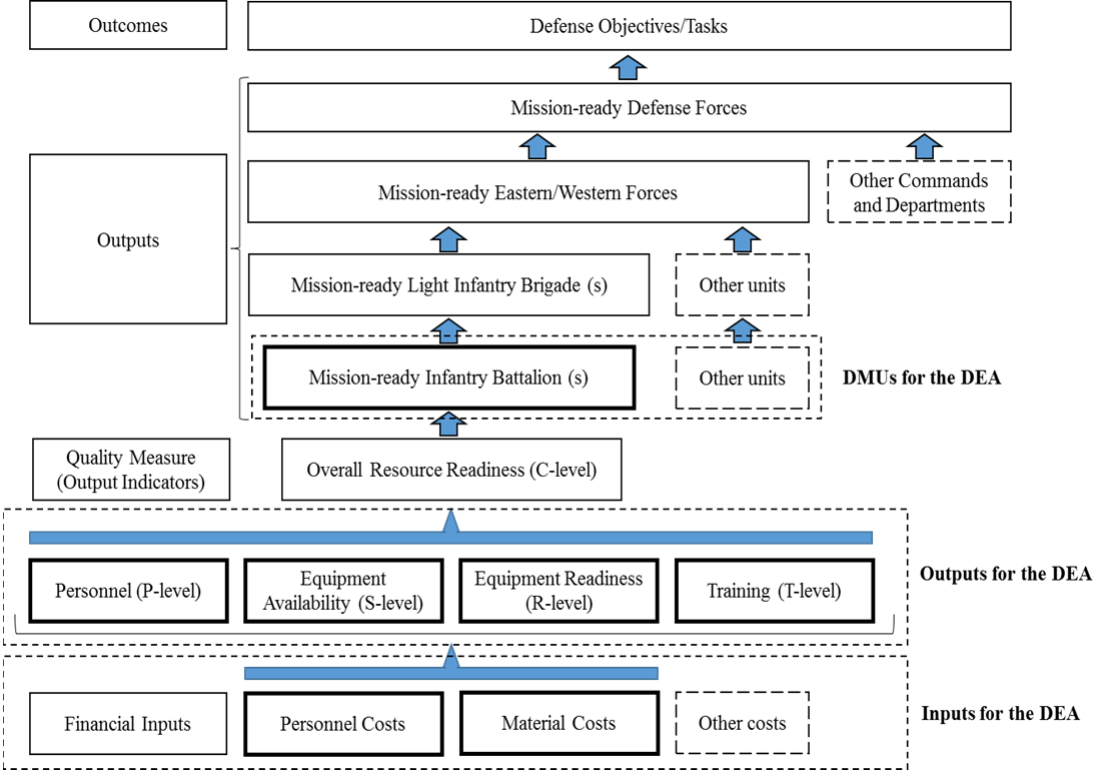
Figure 2. Data model for the